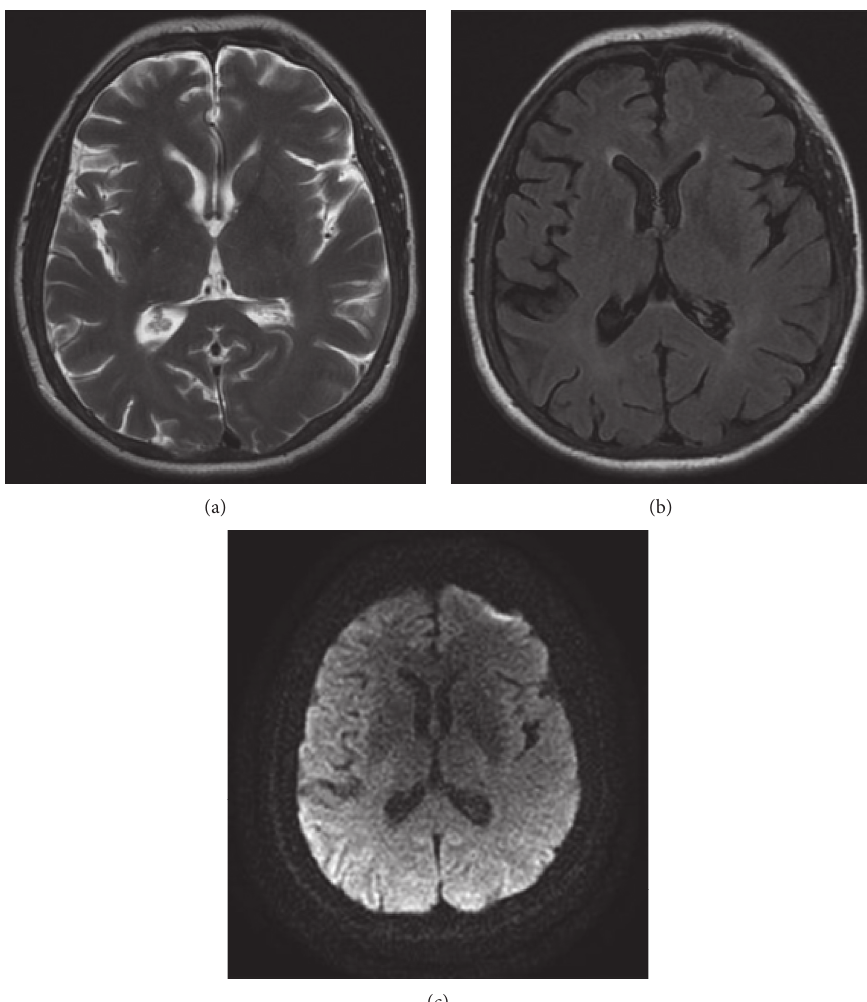
Figure 3: Follow-up brain MR-T2 (a), FLAIR (b), and DWI (c) axial images obtained in another facility 1 month after the initial MR shows complete resolution of the